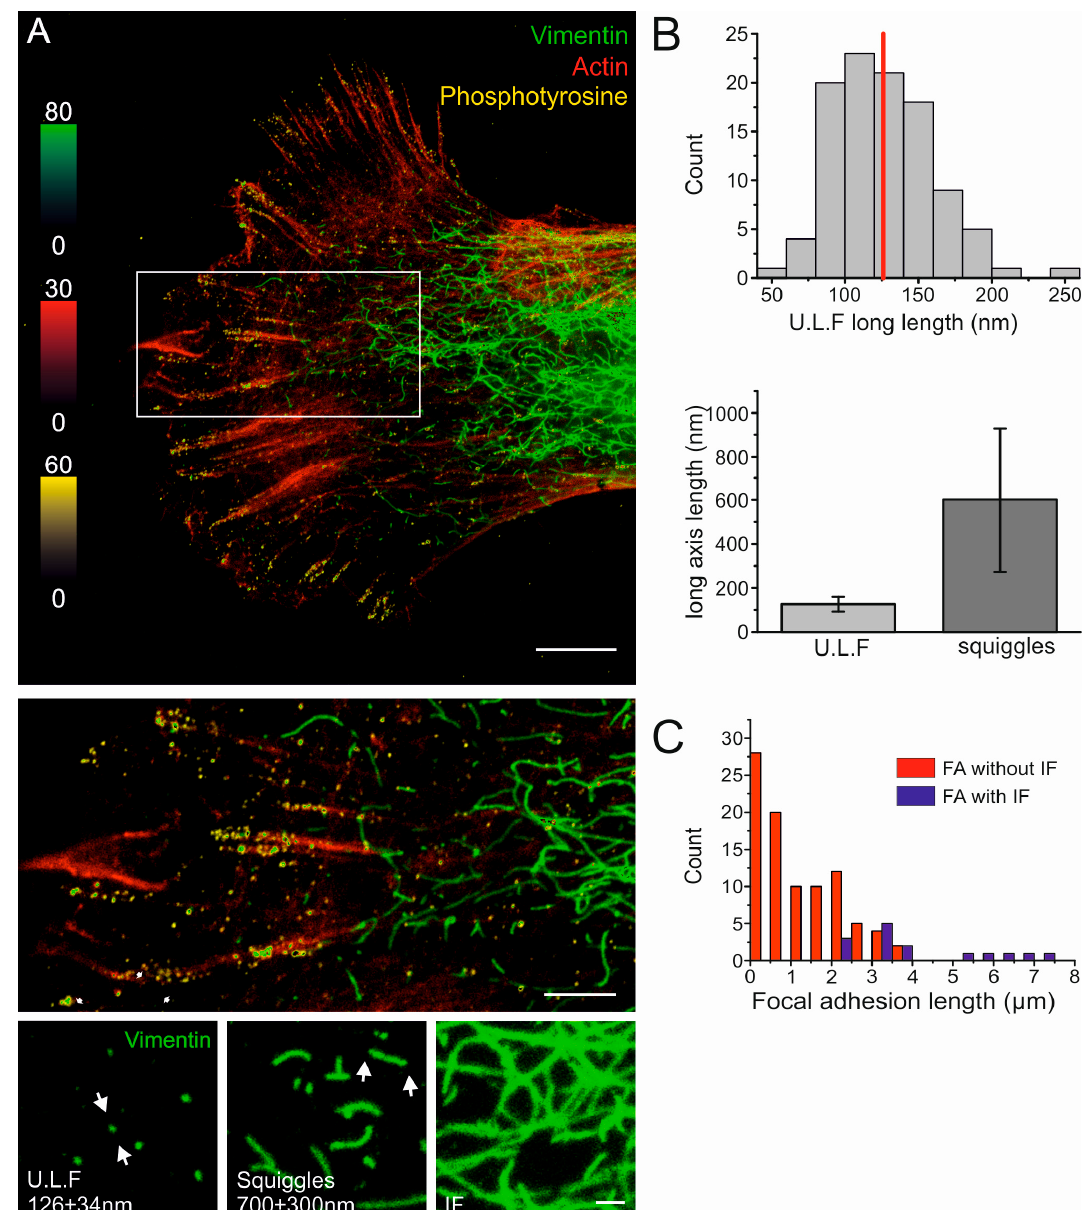
Figure 1. The nanoscale spatial distribution of vimentin is linked to cell-matrix adhesions. ( A ) Top image: three-color STED image of a representative cell expressing wild-type vimentin fused to an EGFP variant and stained for GFP (green), phosphotyrosine (yellow), and actin (red). Scale bar; 5 µm. Magnification of the area marked with a white box in the top image is shown in the middle panel. Scale bar; 2 µm. Lower panel: zoomed images of the assembly states of vimentin filaments, from single ULFs to mature filaments in different regions of the image. Scale bar; 500 nm. The experiment was performed three times, and representative images of a total of 13 STED images are shown; ( B ) top panel: distribution histogram of the measured ULF vimentin lengths, with a vertical red line indicating the median. Below: bar plot showing the lengths of ULFs and squiggles along their long axis; and ( C ) distribution histogram of FA lengths in close spatial association with the presence (blue) or absence (red) of vimentin filaments.